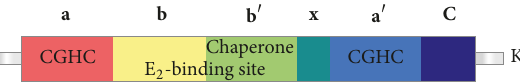
Figure 1: Domain structure of PDI.